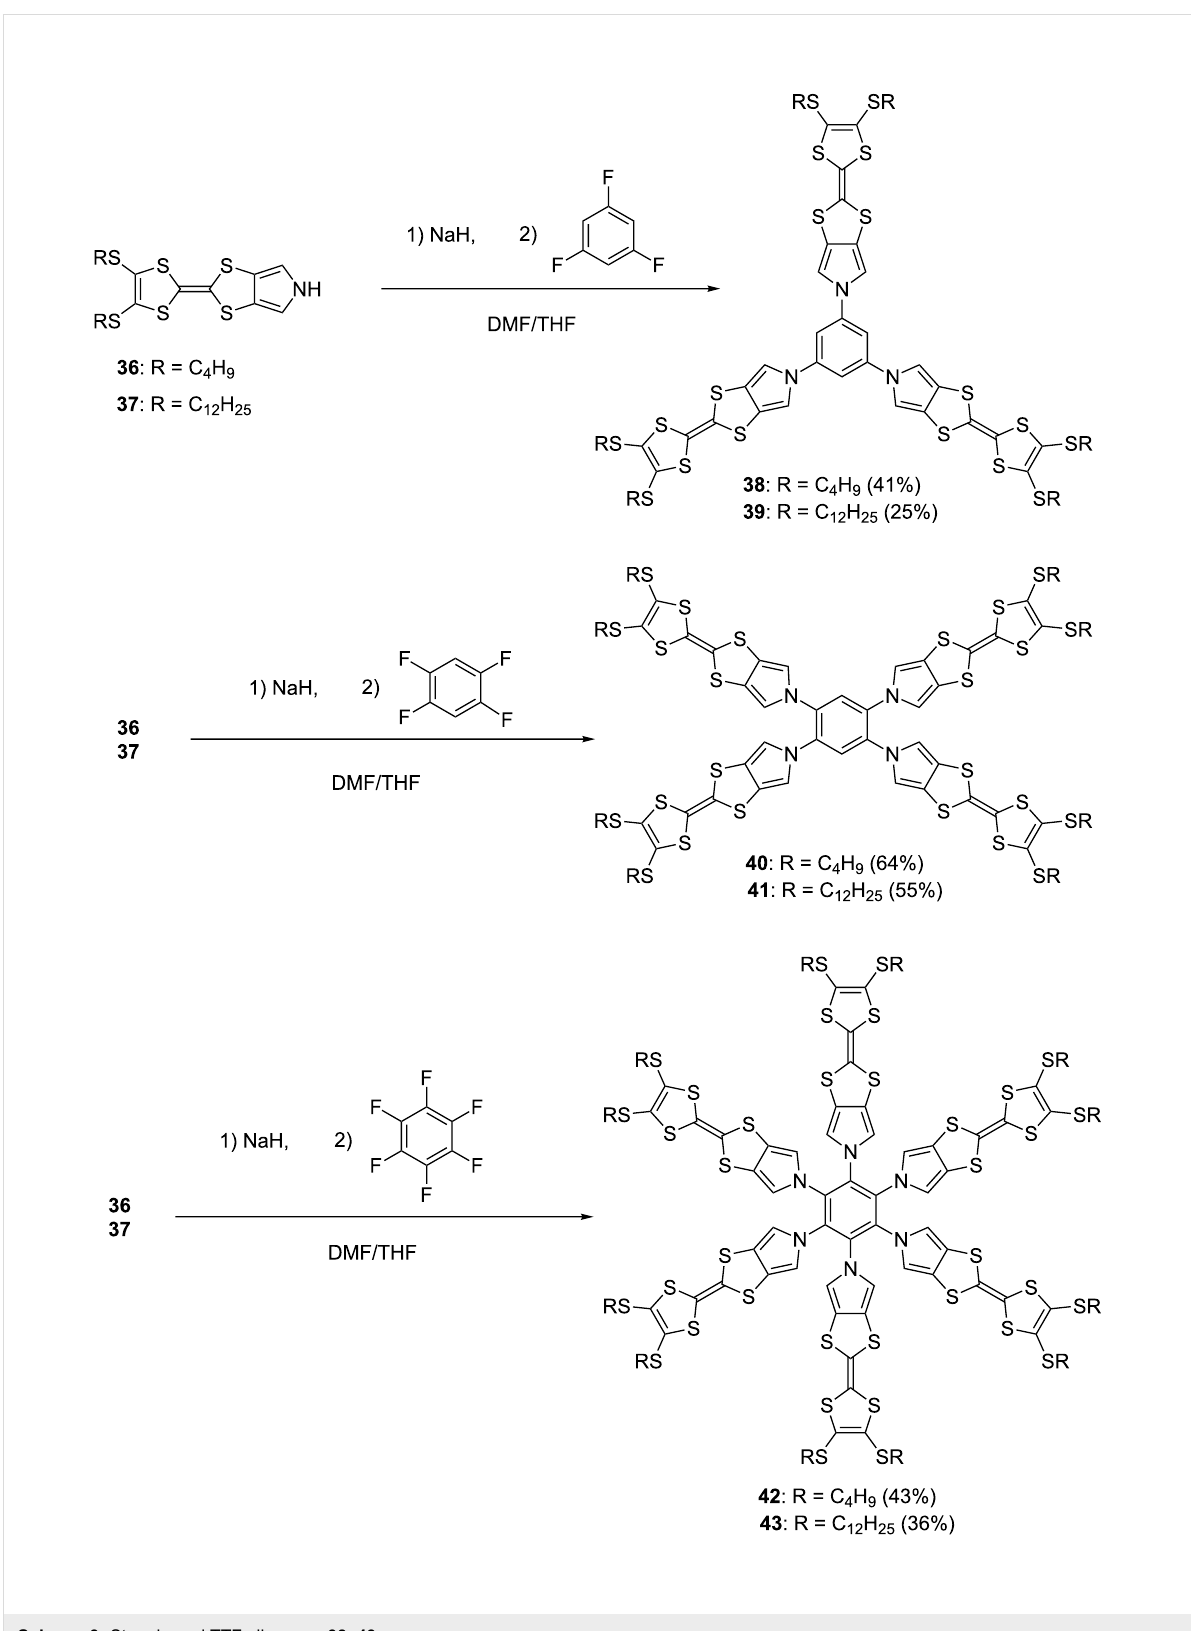
Scheme 3: Star-shaped TTF oligomers 38–43